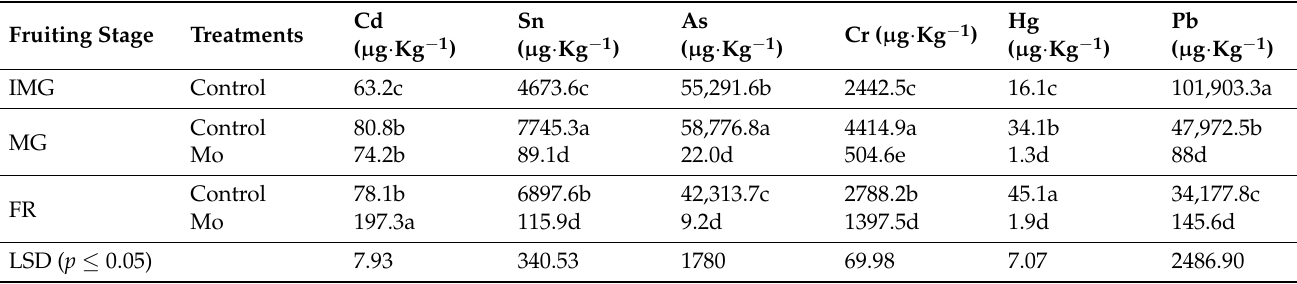
Table 4. Concentrations of heavy metals in loquat leaves affected by the foliar application of molybdenum. Fruiting Stage